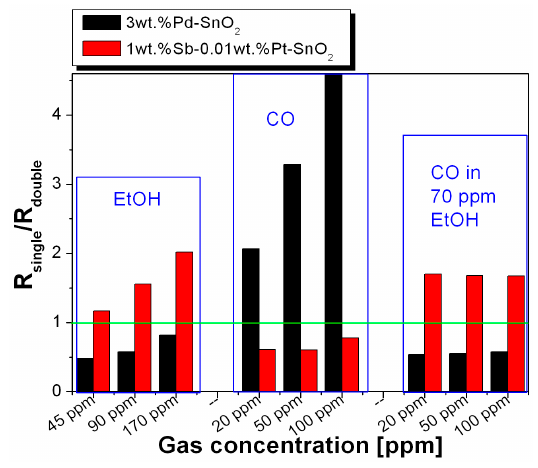
Figure 5. Resistance ratios of the single and the double layers.